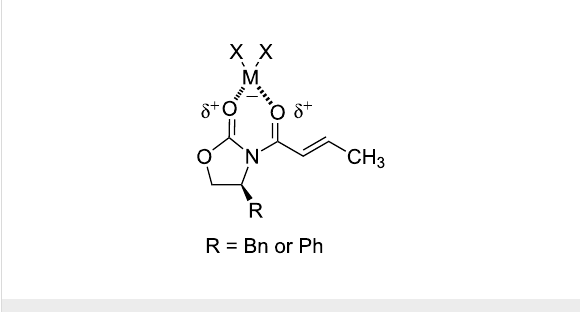
Figure 3: Lewis acid complex of the Evans auxiliary